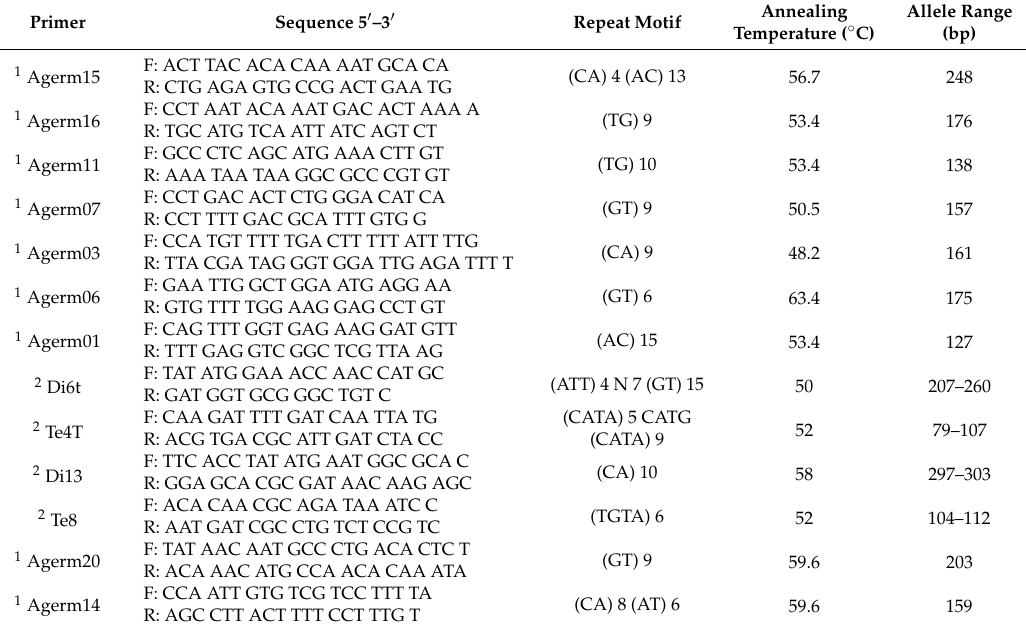
Table A1. Microsatellite loci for Avicennia germinans showing the primer sequences, the annealing temperature and the size range in base